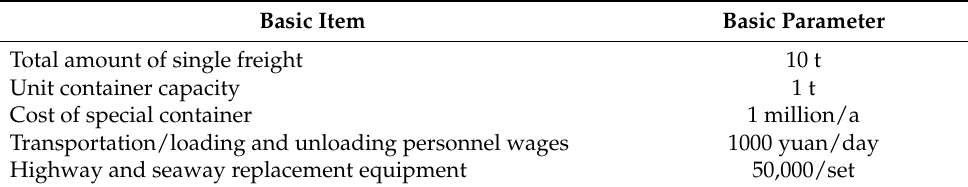
Table 1. Key parameters for model